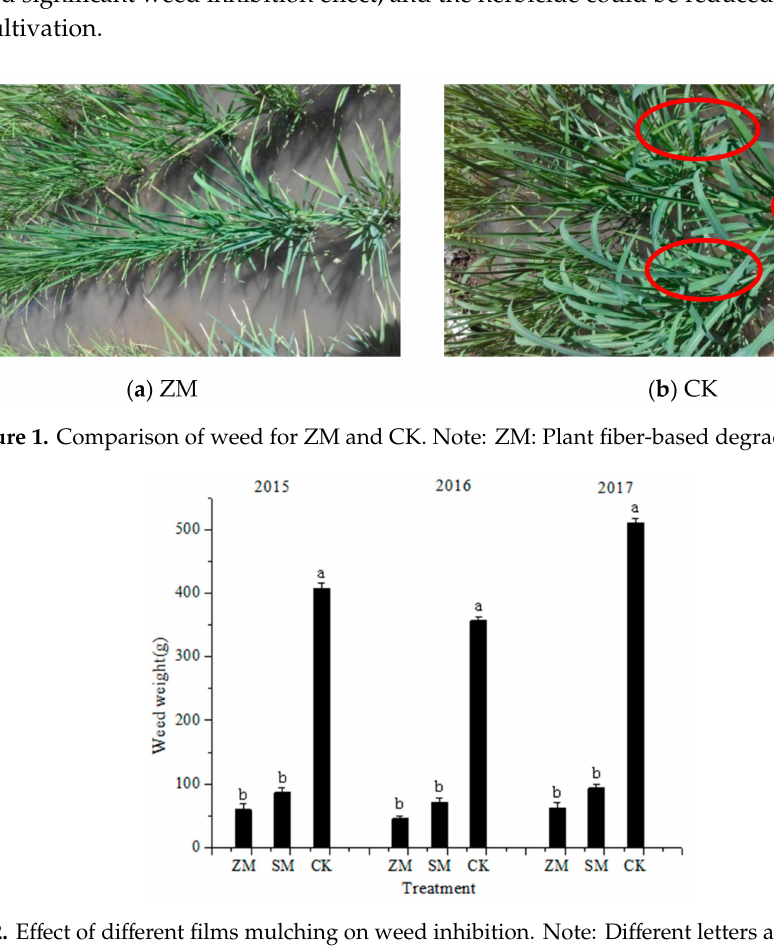
Figure 2. E ff ect of di ff erent films mulching on weed inhibition. Note: Di ff erent letters are significantly di ff erent within the same year among treatments at the 0.05 probability